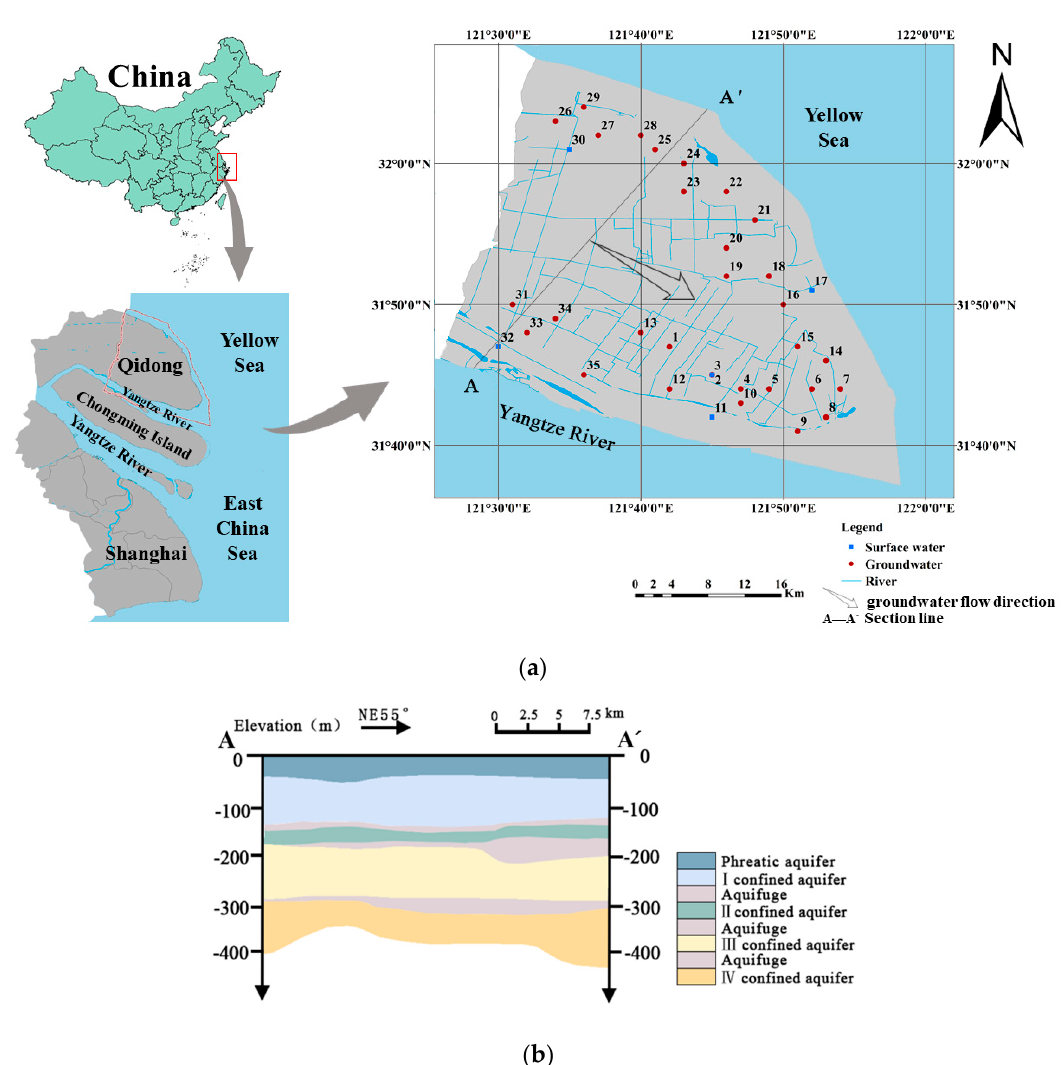
Figure 1. Location of study area and well sampled in the littoral zone of Qidong ( a ), hydrogeological cross section of study area ( b ) (modified from [40] ).